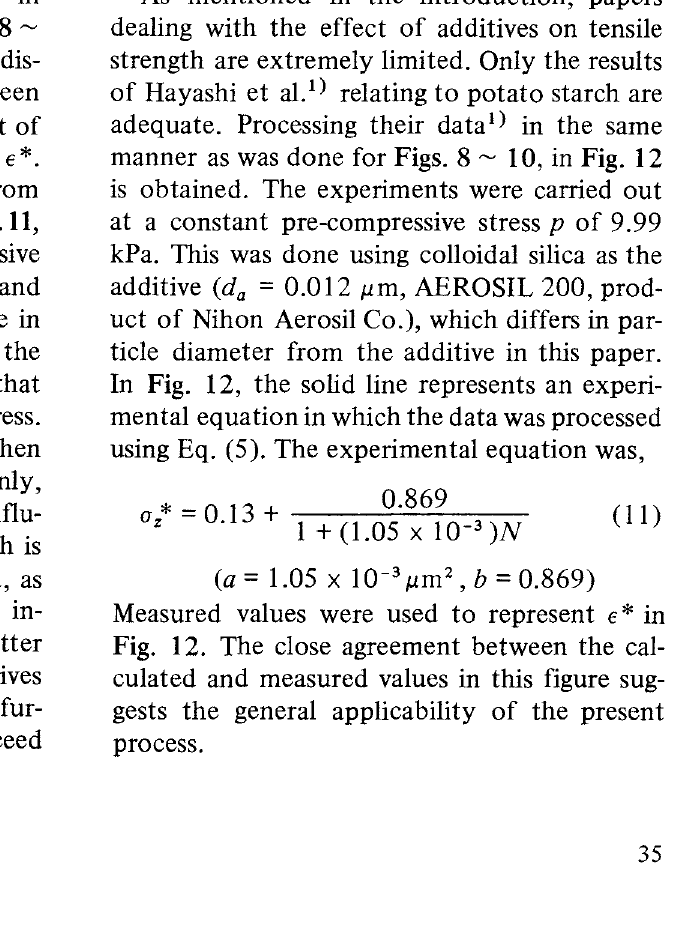
Fig. 9 Relationship between az* and E* (lactose) (1: n~O.OOS, ll: 0.005~n~O.Ol, ill: 0.01 ~n)